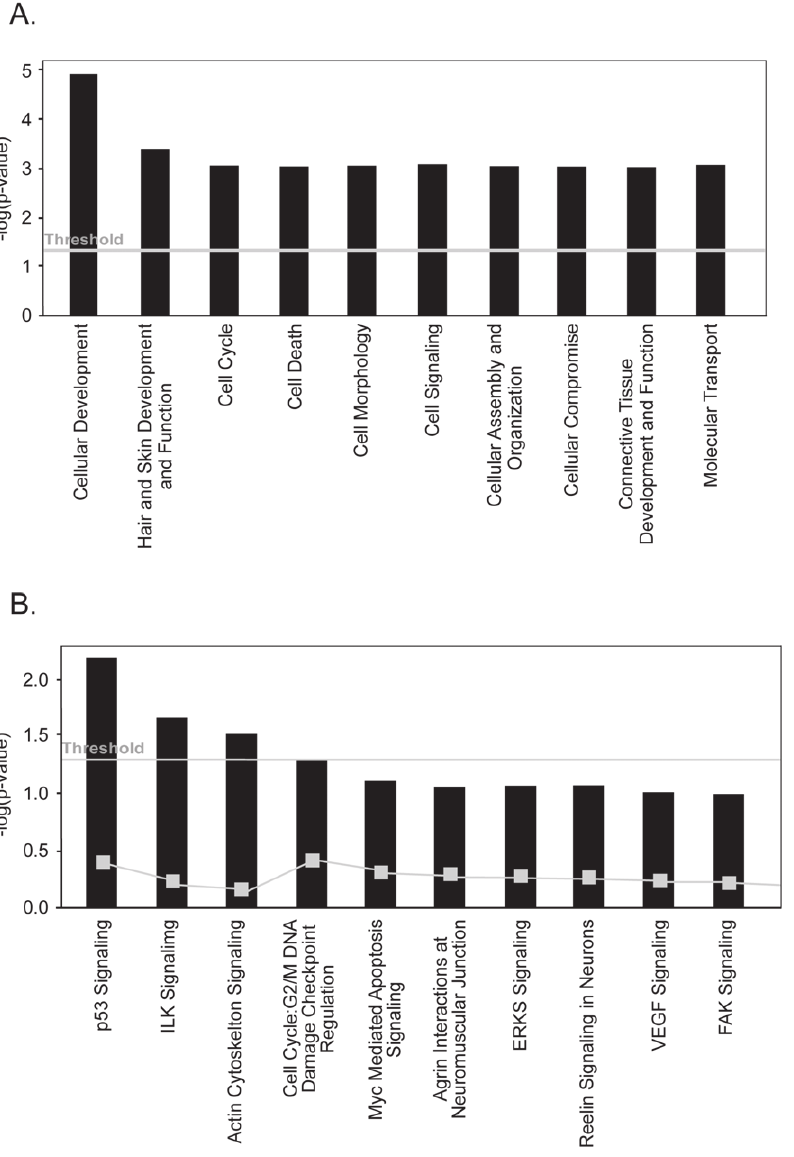
Figure 4. Identification of signaling pathways and interaction of gene products associated with cellular response of cancer cells towards formulated arsenic trioxide. The genes identified by COMPARE analyses ( Table S1 ) were subjected to Ingenuity Pathway Analysis Software. ( A ) Top 10 categories of biological functions of the candidate genes. ( B ) Top 10 canonical signaling pathways, which the candidate genes were assigned